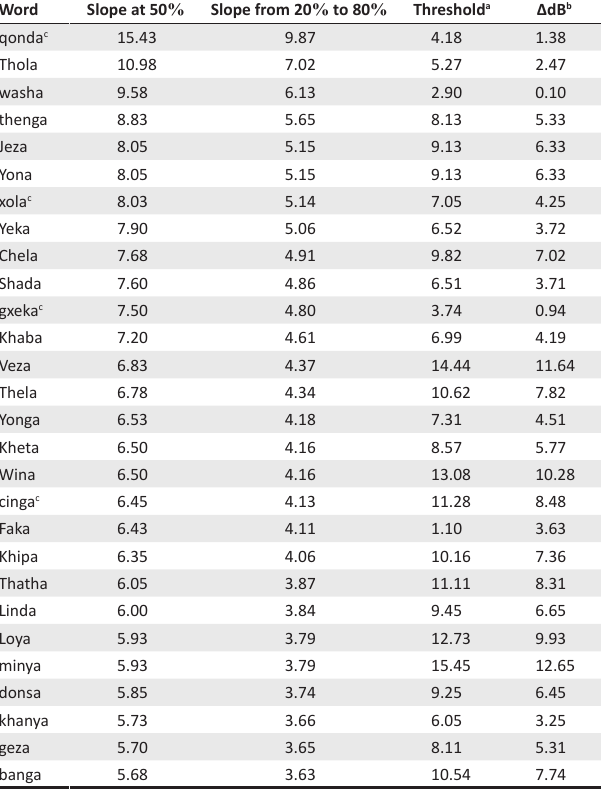
TABLE 1: Psychometric properties of the 28 disyllabic isiZulu word recordings used in this study. Word Slope at 50